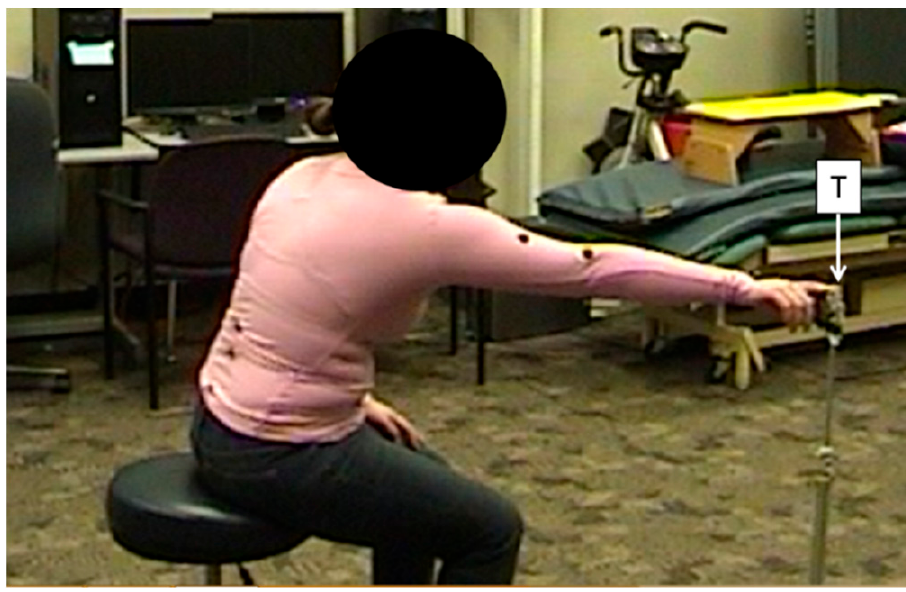
Figure 1. An example of a participant reaching towards the target (T) during an extended scaption reach while wearing retroreflective markers.